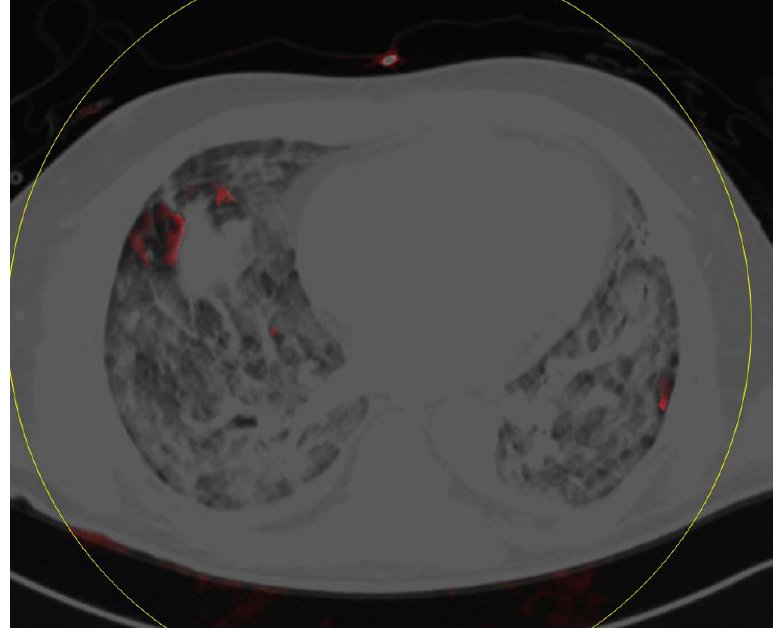
Figure 6. This patient shows extensive perfusion defects as well as opacities in both lower lobes (perfusion defect score 4; opacity score